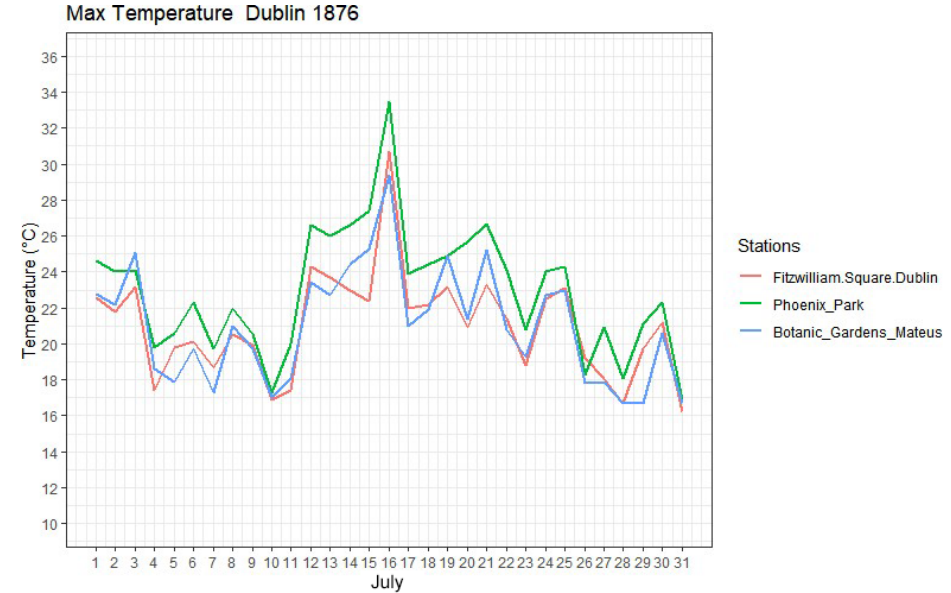
Figure 11. The maximum surface temperatures of all available stations in Dublin City during June